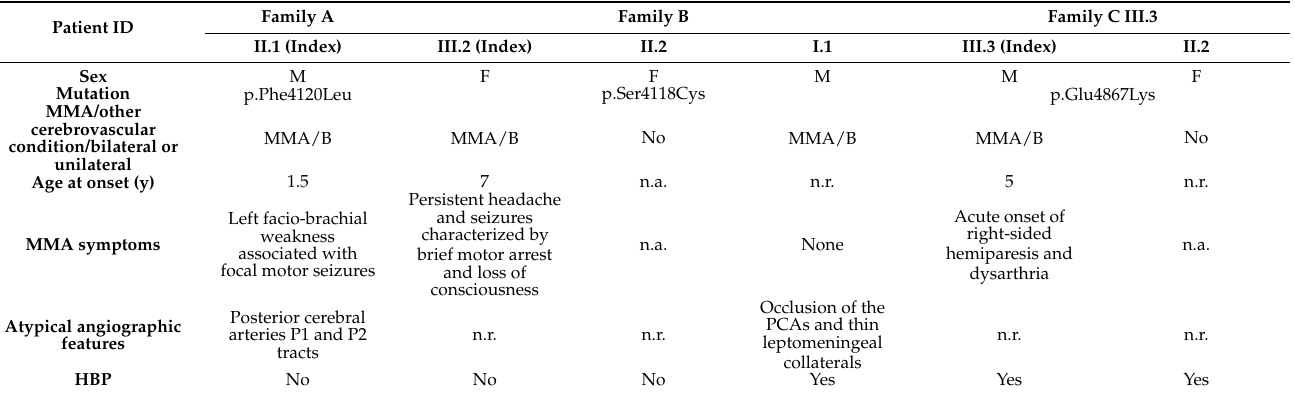
Table 1. Demographical, clinical, and radiological features of our